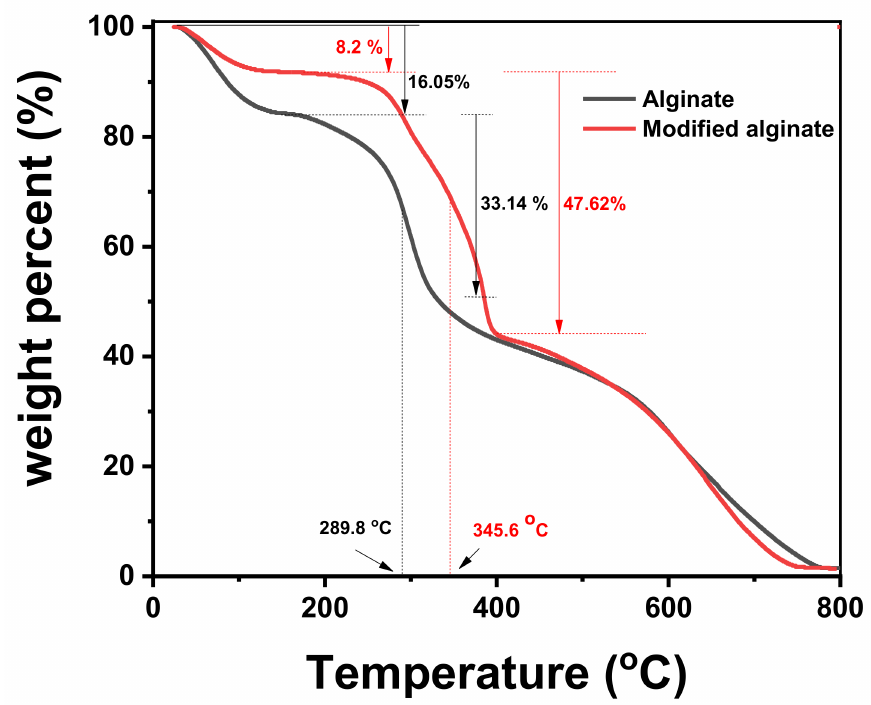
Figure 3. TGA of alginic acid and its aromatic